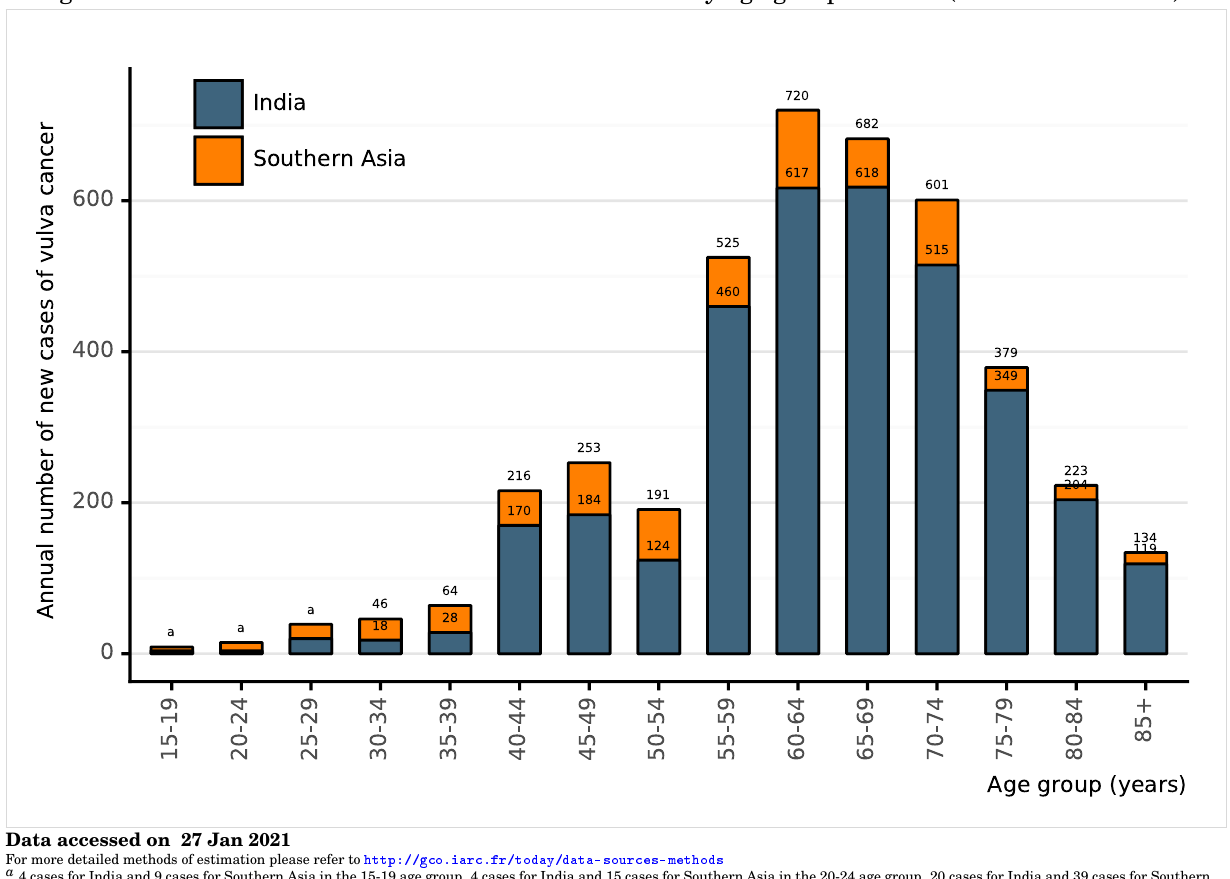
Figure 82: Annual number of new cases of vulva cancer by age group in India (estimates for